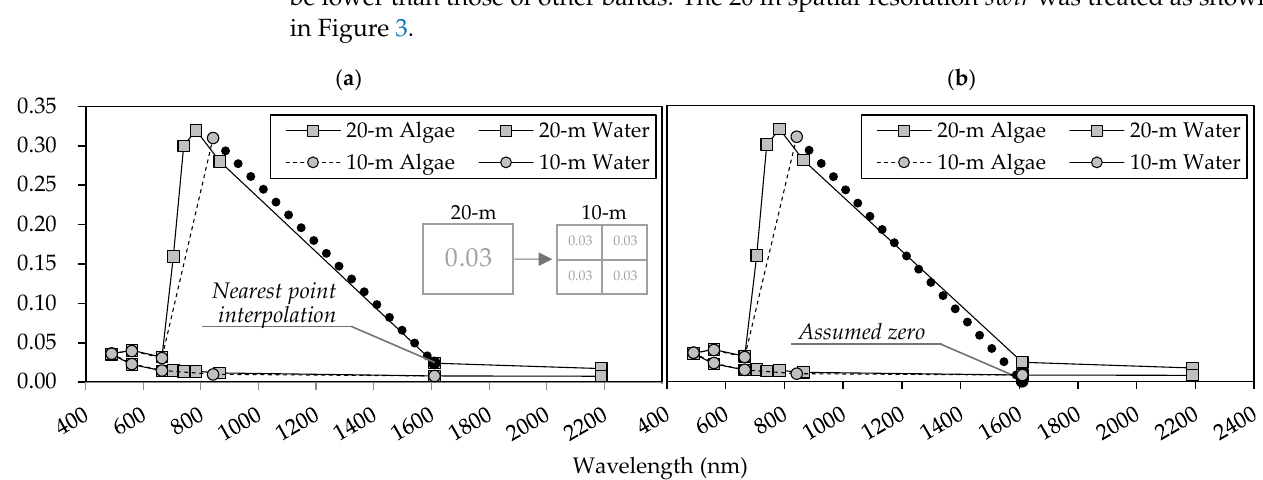
Figure 3. De fi nition of shortwave infrared (SWIR) in Sentinel-2 satellite data with 10 m spatial resolution: ( a ) nearest-point interpolation (FAI-a) and ( b ) assumed zero re fl ectance (FAI-b). The details of these methods are found in the main text.